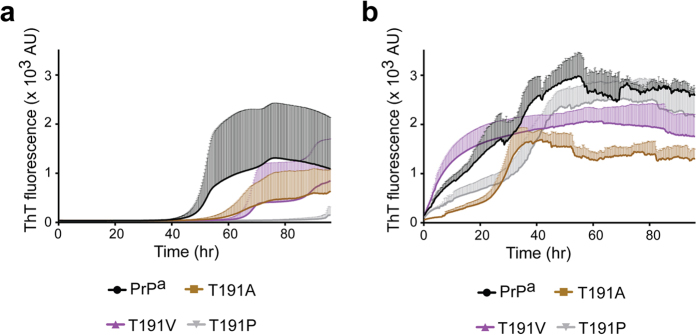
Amyloid fibril growth with recombinant PrPT191A, PrPT191V, or PrPT191P.ThT kinetics of recombinant PrPa, PrPT191A, PrPT191V, or PrPT191P in the absence (a) or presence (b) of seeds (pre-formed recPrPa amyloid fibrils). Shaded areas are error bars, which indicate standard deviation.